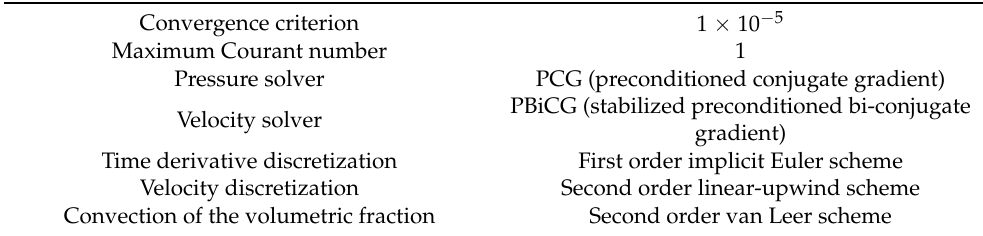
Table 5. Numerical settings used in the simulations.